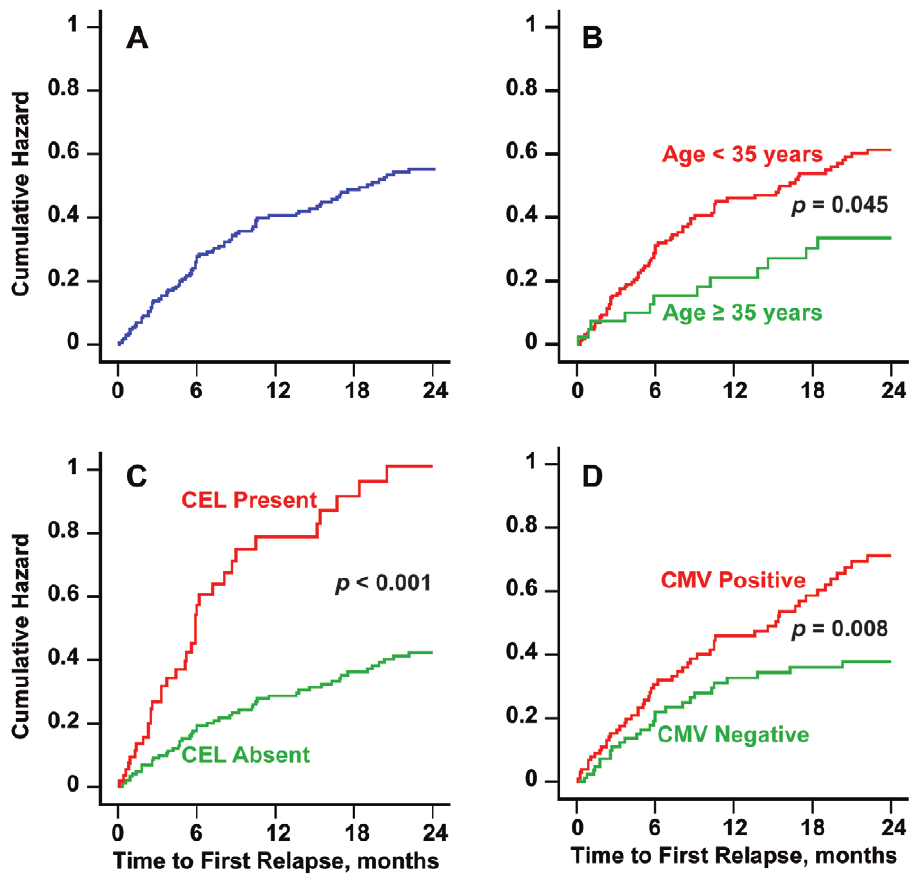
Figure 1. Dependence of time to first relapse on demographic, MRI and environmental factors. Figure 1A shows the cumulative hazard function for time to first relapse in all subjects. Figures 1B-D show the cumulative hazard functions for the age , 35 years (red line) vs. age $ 35 years (green line), CEL present as baseline (red line) vs. CEL not present at baseline (green line) and CMV positive (red line) vs. CMV negative sub-groups, respectively. The corresponding covariate p -values from Cox regression are also